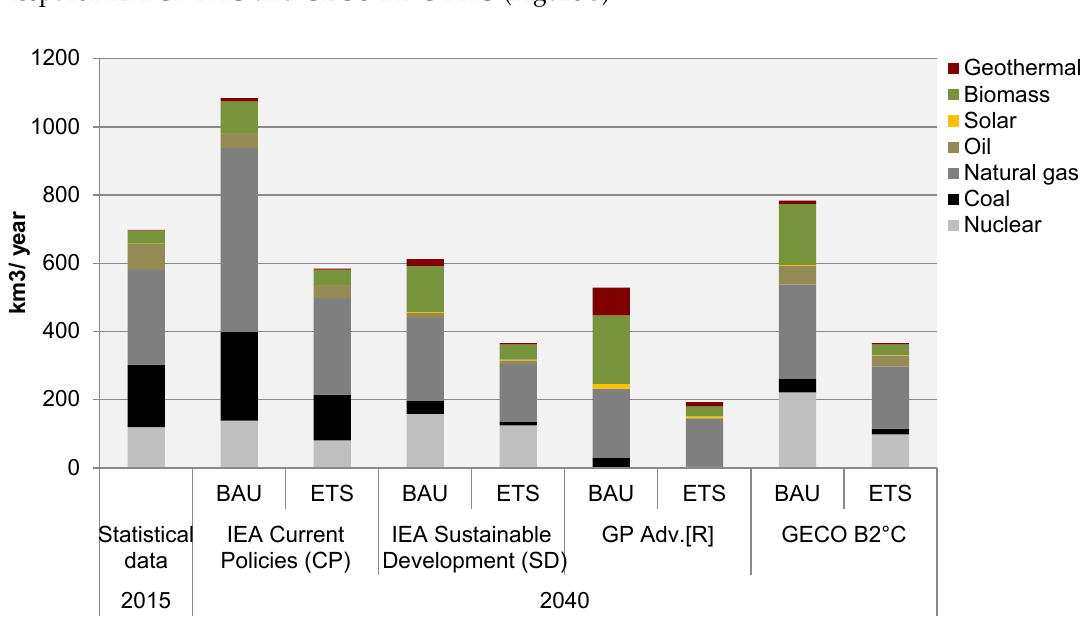
Figure 3. Water withdrawal (in km 3 per year without 1T-BSW) for electricity generation by energy source (excluding hydropower) for the year 2015 and the four energy scenarios in combination with changes in the power plant type and cooling technologies (BAU and ETS scenarios) in 2040. (Source: own calculation based on the data from [39–41]).